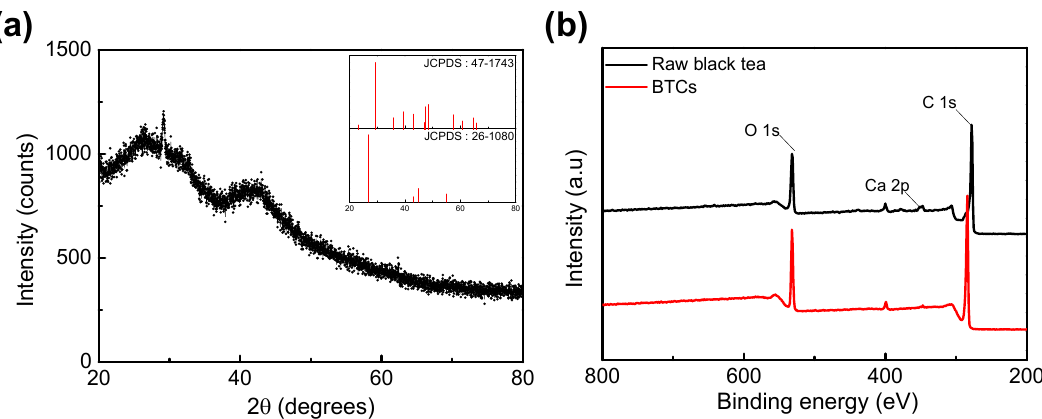
Figure 3. ( a ) XRD spectrum BTC (Inset: JCPDS patterns of CaCO 3 (No. 47–1743) and carbon (No. 26-1080)). ( b ) XPS spectrum of raw black tea and BTCs.